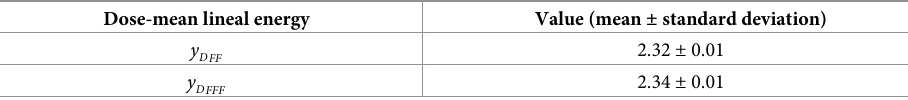
Table 2. Average value of the dose-mean lineal energy y D for FF and FFF